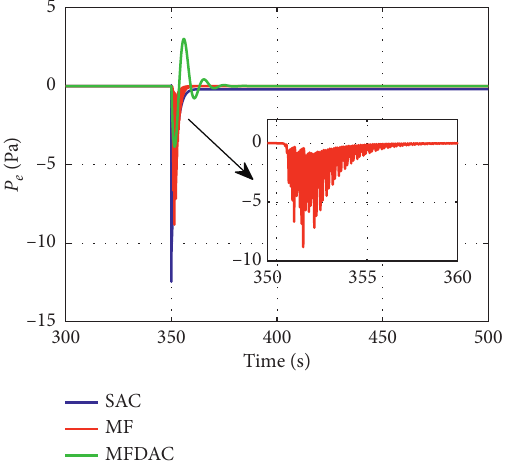
Figure 16: Pressure error of the actuator fault after reconfiguration.